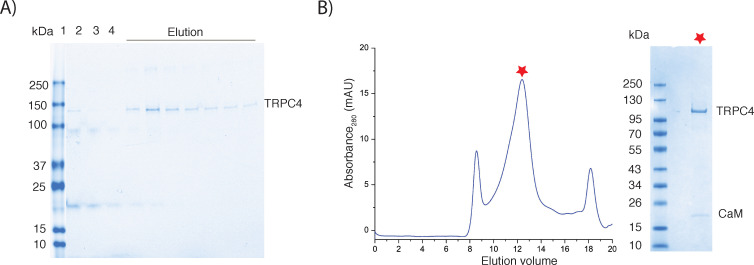
Analysis of CaM binding to TRPC4 by biochemical methods.(A) SDS gel electrophoresis analysis of the TRPC4 pull down experiment performed with a CaM Sepharose column. Lane 1 - protein size marker, lane 2 - TRPC4 input, lane 3 - flow through, lane 4 - wash, remaining lanes - elution fractions. (B) Gel filtration analysis of the TRPC4-CaM complex. The peak fraction containing the TRPC4-CaM complex is indicated by a star were further analyzed by SDS gel electrophoresis (right panel).